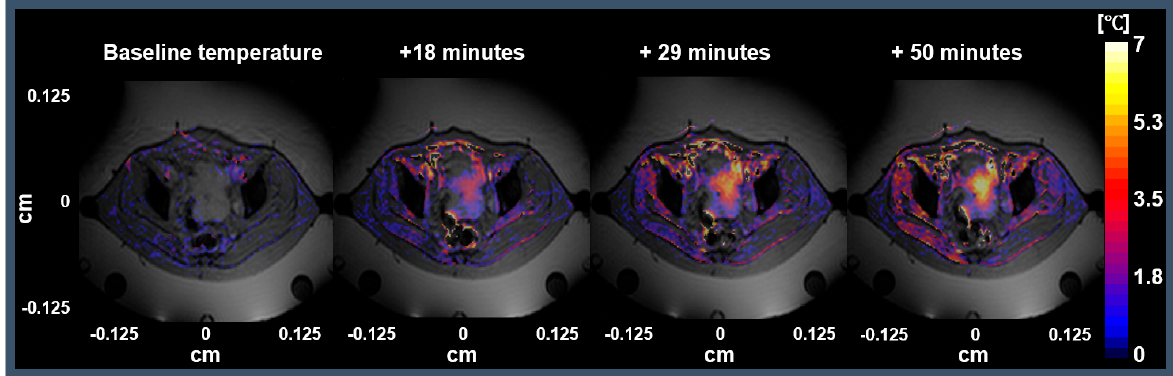
Figure 5. Representative session with Jaccard coefficient equal to 1 and the gastrointestinal air volume was equal to 221 mL. The first image represents the MR thermometry map between the phase images of S 00 and S 01 . The following three images represent the MR thermometry maps after 18, 29, and 50 min from when RF power was applied (treatment start).